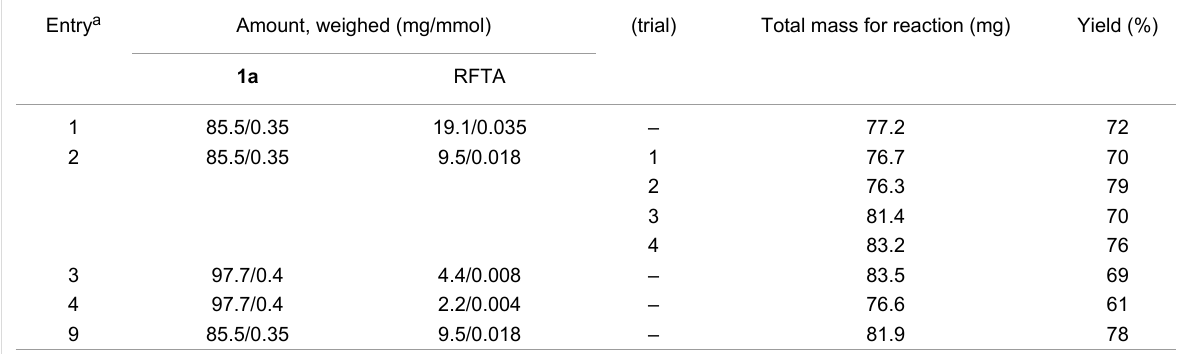
Table 2: Amounts of 4,4’-dimethoxybenzhydrol ( 1a ) and riboflavin tetraacetate (RFTA) and yields for the oxidation to 4,4’-dimethoxybenzo- phenone ( 1b